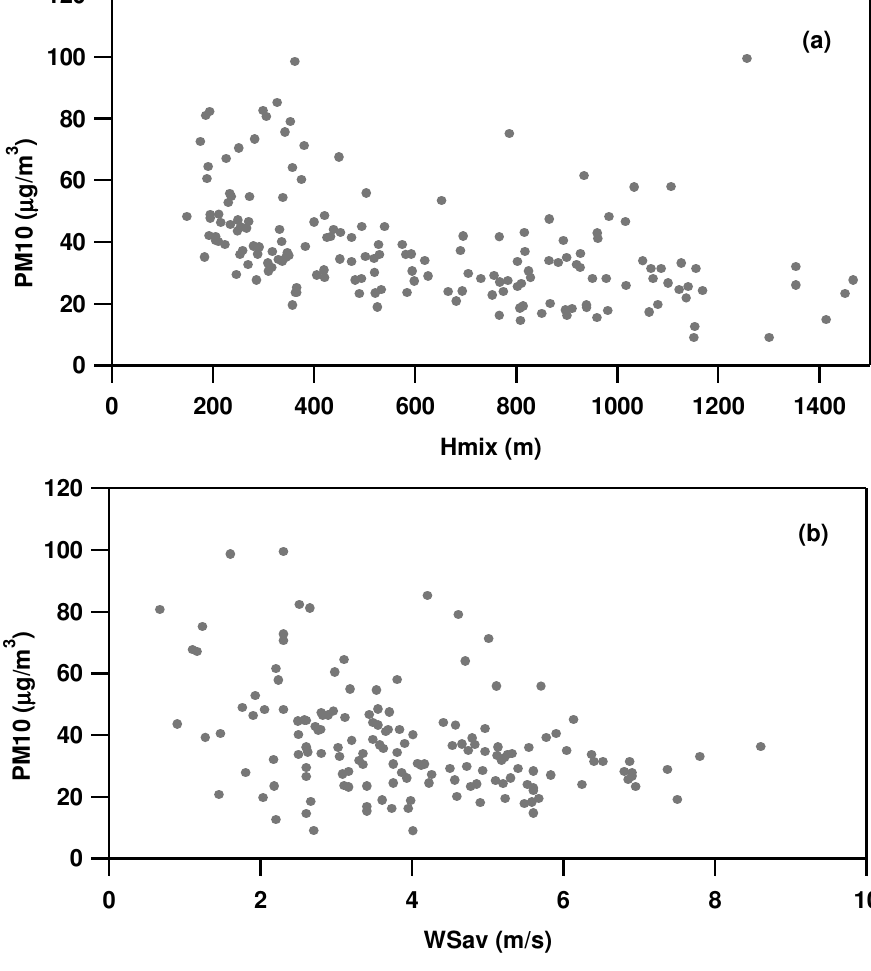
Figure 12. Scatterplot of Arnesano-PM10 mass concentrations versus clear-sky AOTs/Hmix values for (a) 2006, (b) 2007, and (c) 2008. Slope, intercept and linear correlation coefficient ( R ) are also given in each plot in addition to the total number of data points ( N